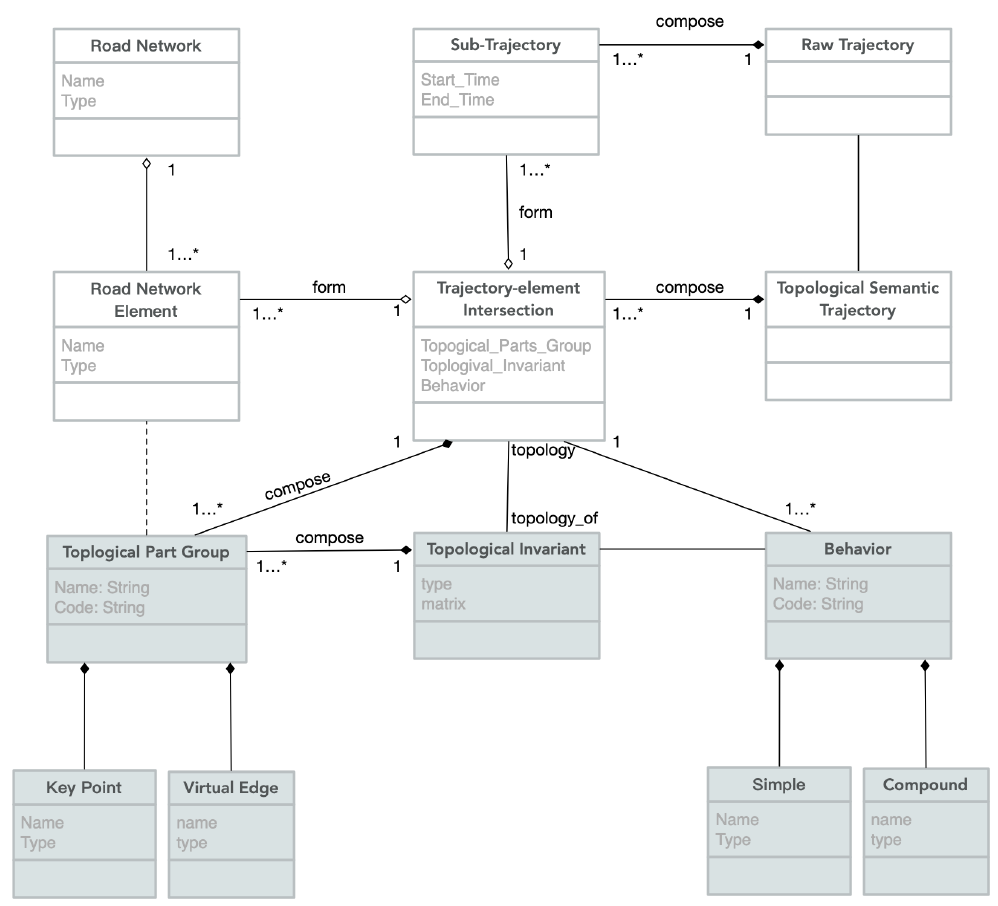
Figure 1. A conceptual data model for topological semantic trajectories inside road